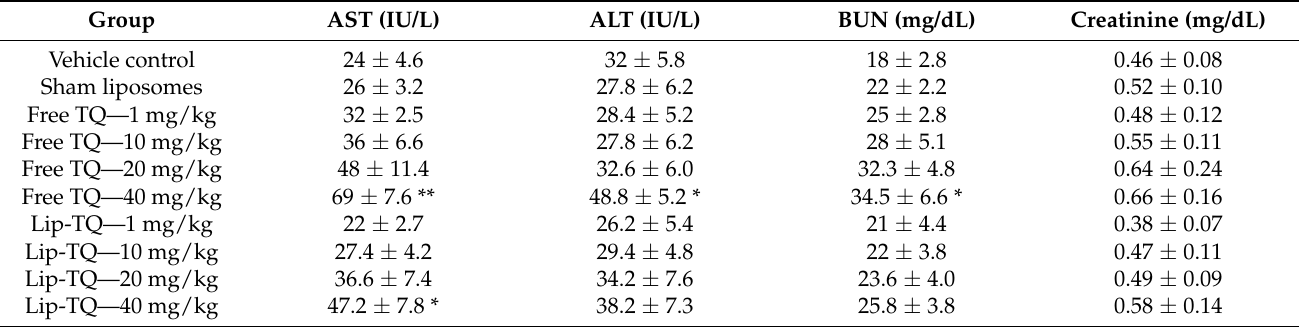
Table 3. Effect of free TQ or Lip-TQ on hepatic and renal